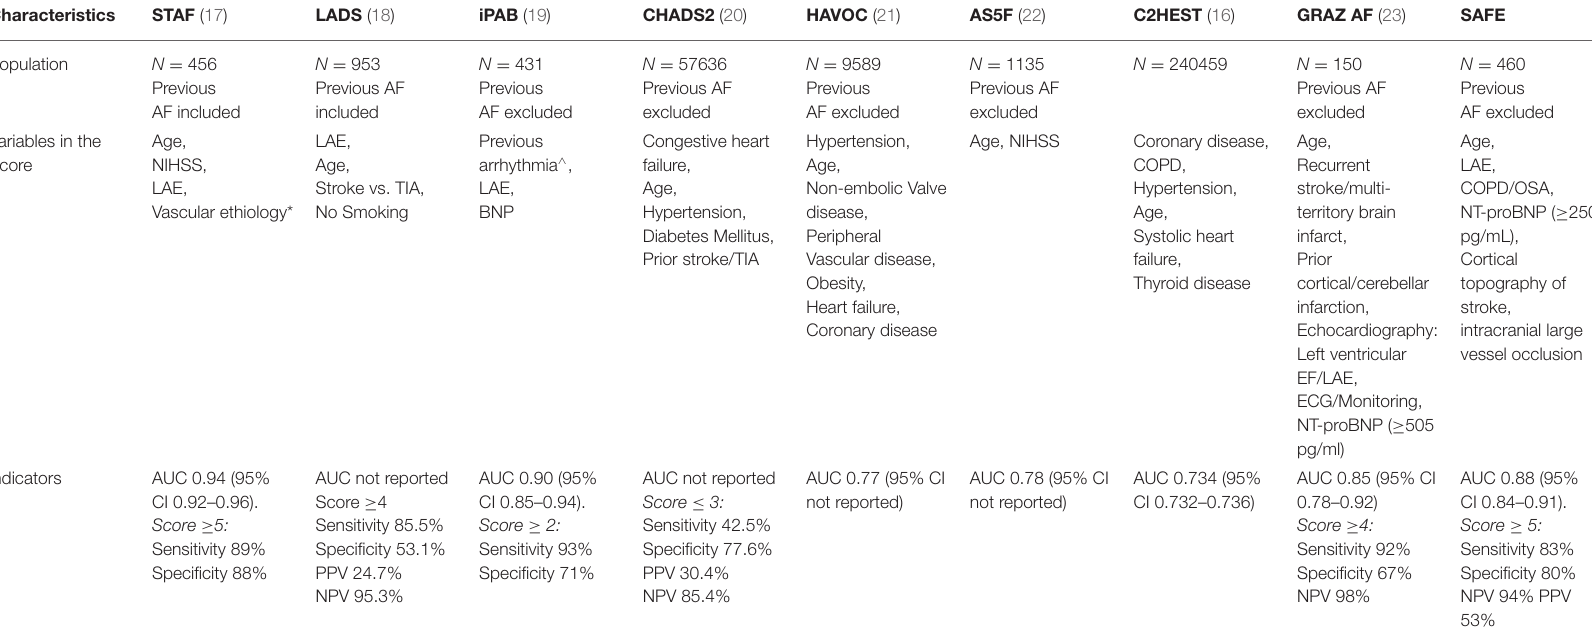
TABLE 3 | Characteristics of previously developed AF predictive scales and the SAFE